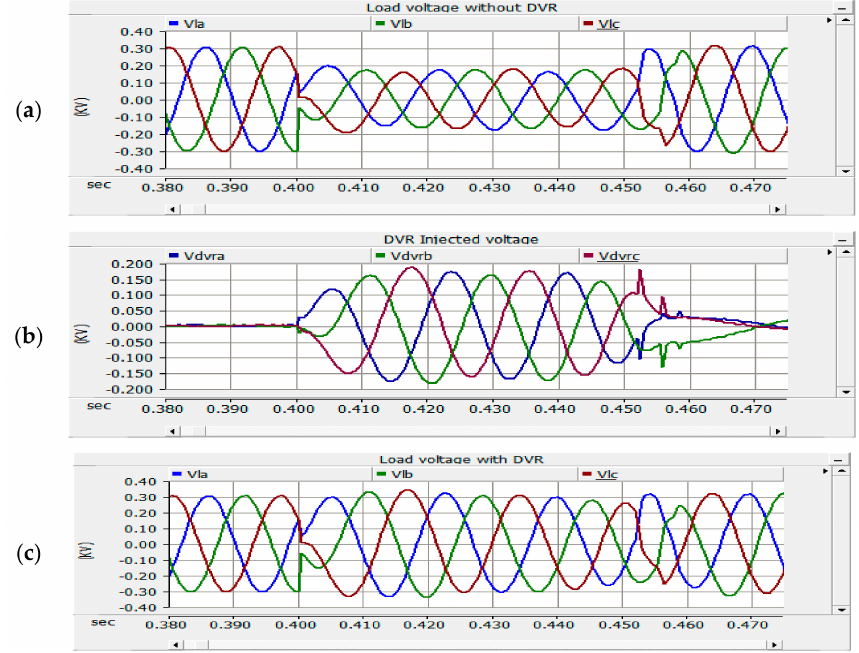
Figure 13. 40% symmetrical phase voltage sag and compensation: ( a ) load voltage without DVR; ( b ) DVR injected voltage; ( c ) load voltage with DVR.